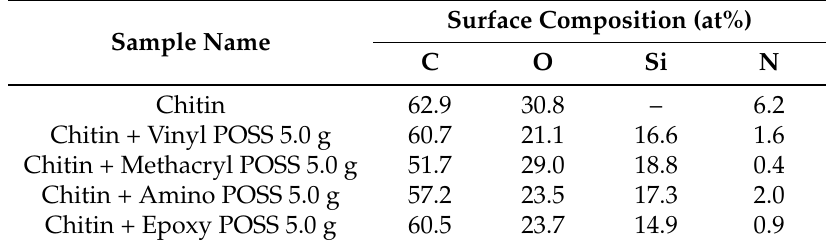
Elemental composition of the surface of the obtained chitin-polyhedral oligomeric silsesquioxanes (POSS) hybrid materials calculated by XPS